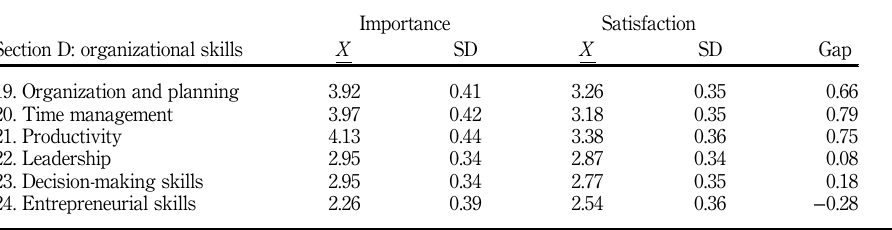
Table VII. The rating of